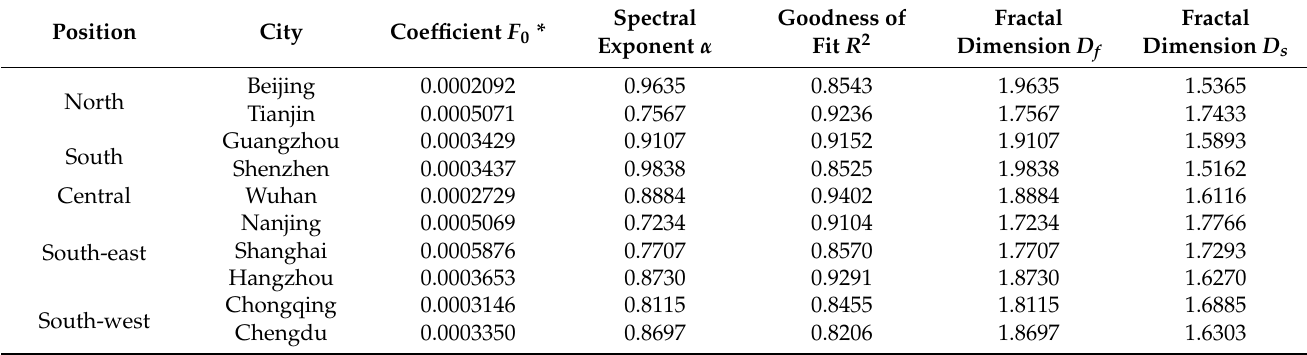
Table 2. Wave spectrum exponents of urban density and corresponding fractal dimension values (2016). Position